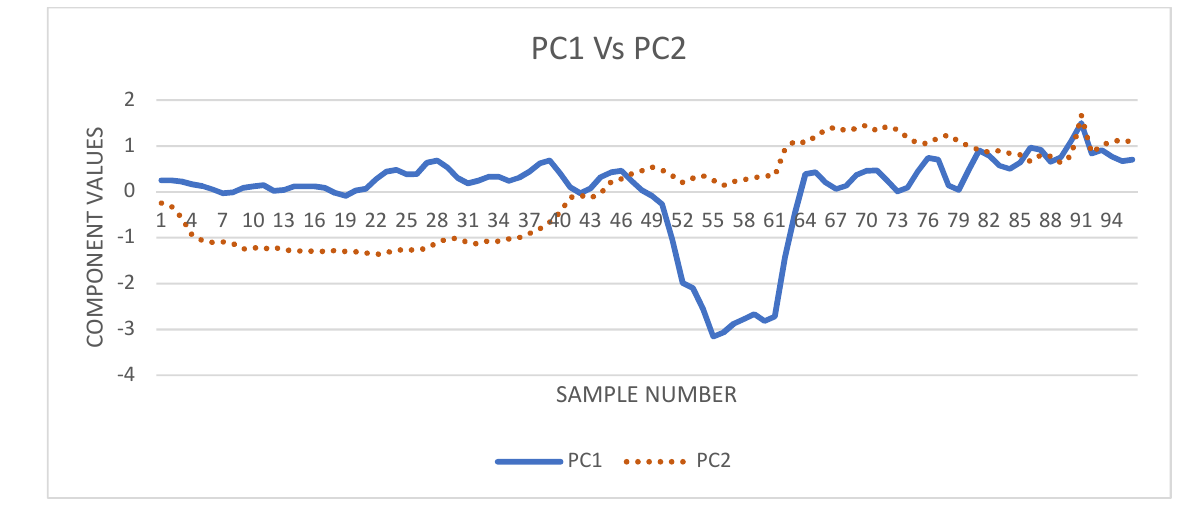
Figure 3. Principal component 1 vs. principal component 2.